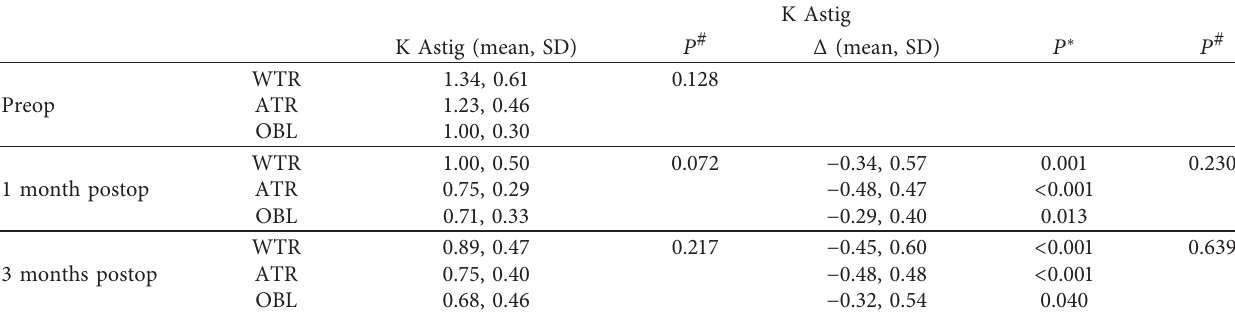
Table 4: Detailed values of changes in these parameters measured by the autokeratometer according to the astigmatism axis. K Astig K Astig (mean, SD)